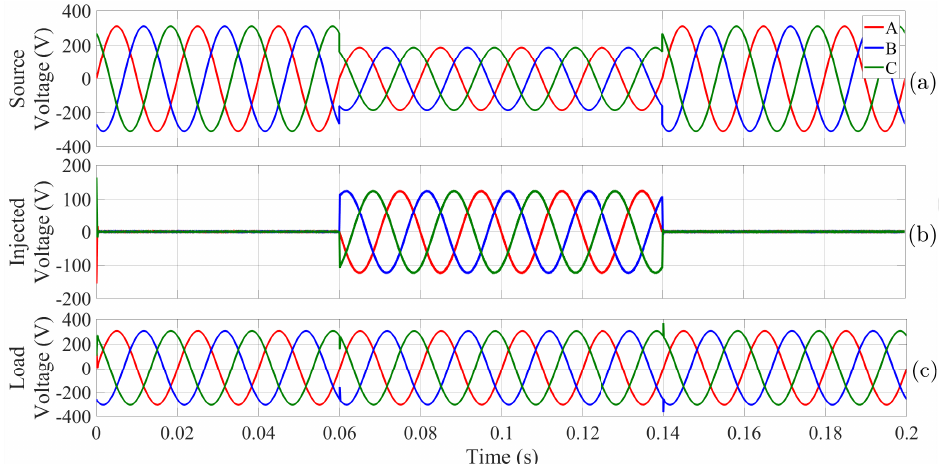
Figure 9. The simulation results of the 40% symmetrical voltage sag with a duration of 80 ms: